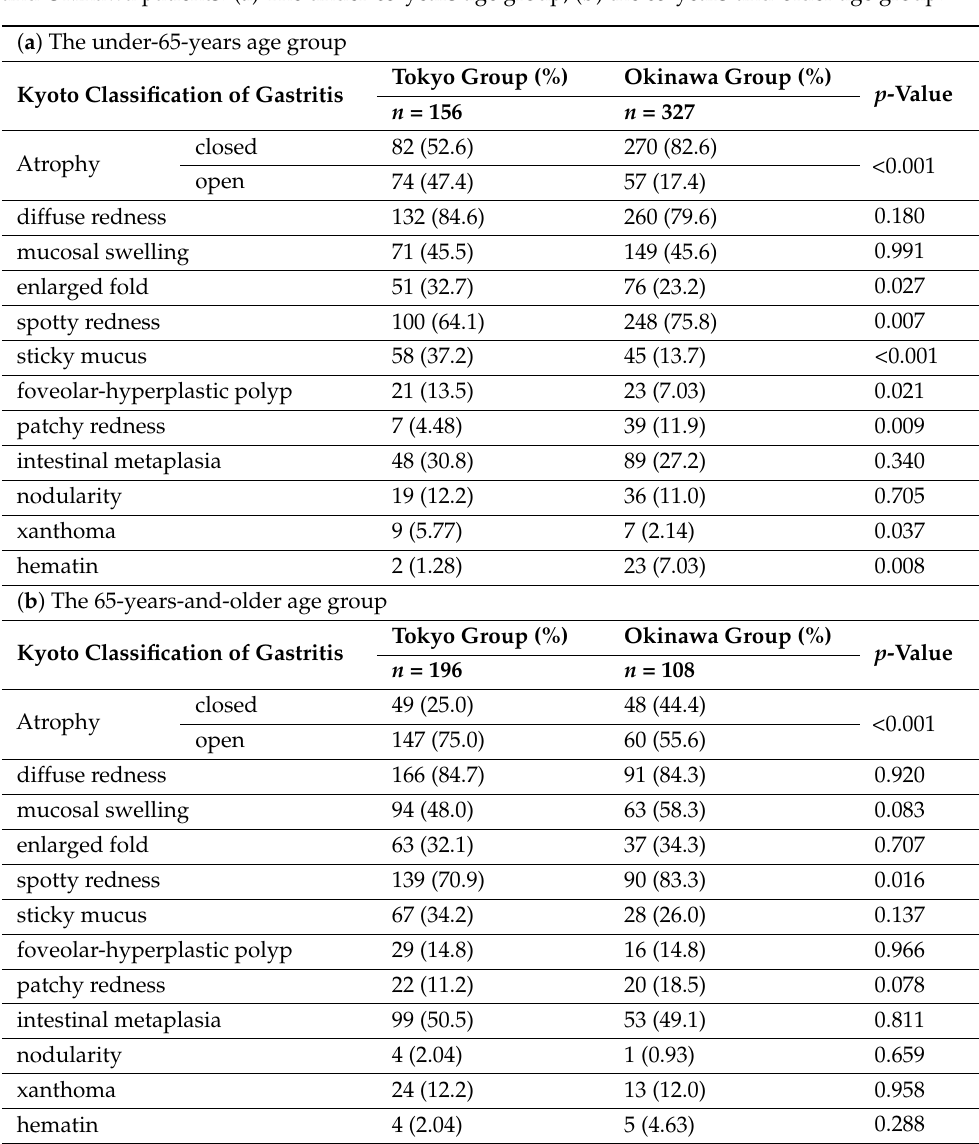
Table 4. Subgroup analyses in each age group below and above 65 years of age between the Tokyo and Okinawa patients. ( a ) The under-65-years age group; ( b ) the 65-years-and-older age